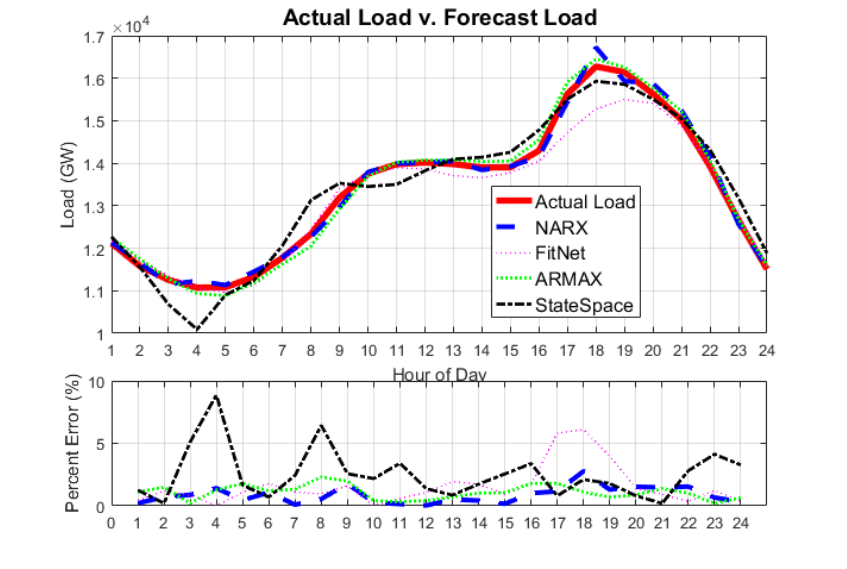
Figure 8. Twenty four-hour actual vs. forecast